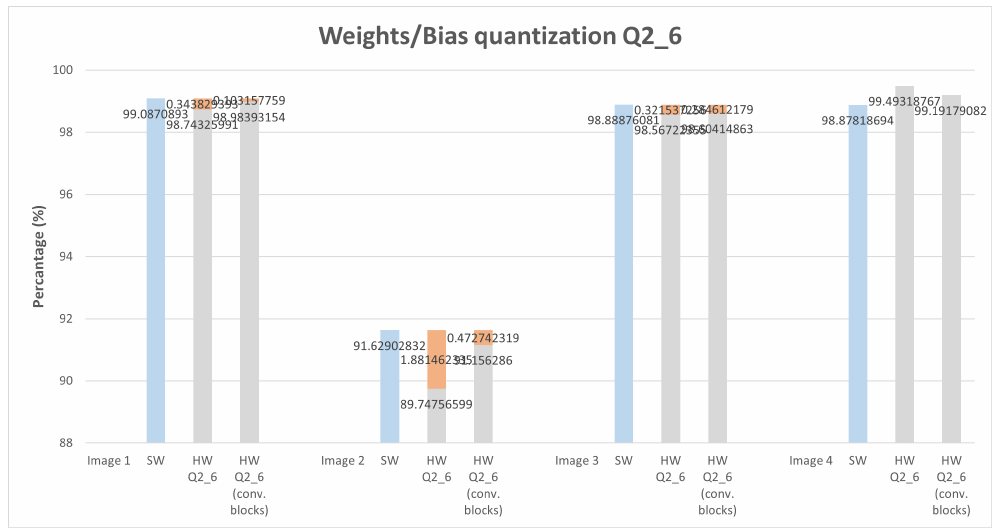
Figure 14. Weight and bias quantization for all MNIST model layers, and only for convolution layers with Q2_6. Orange bar provides difference from SW_version and each hardware quantized